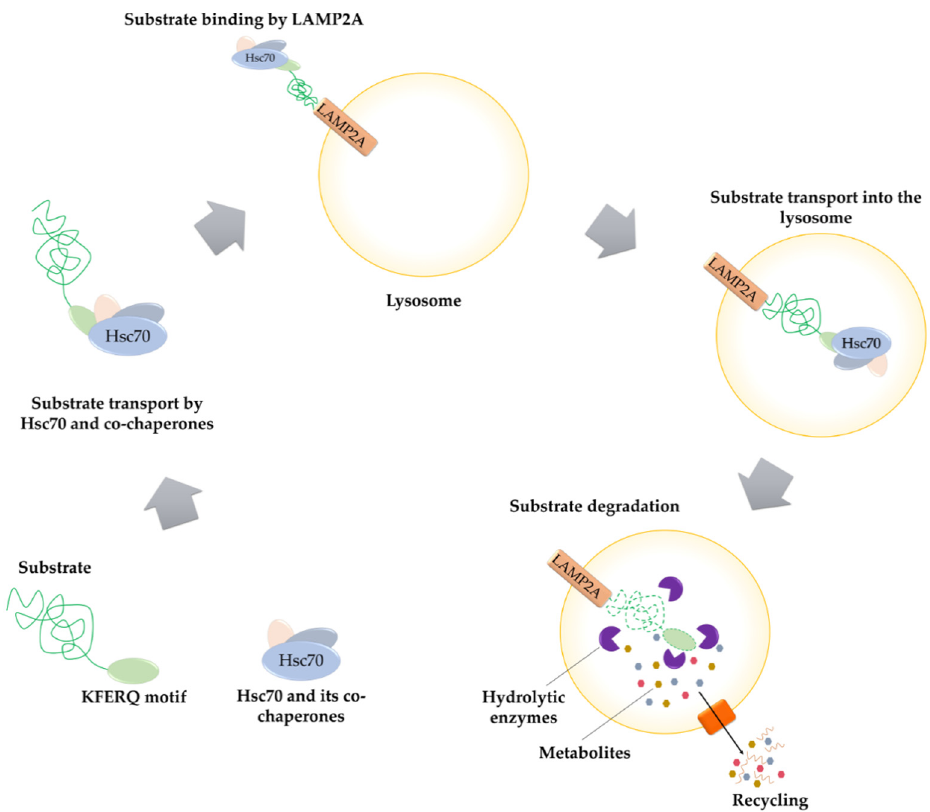
Figure 4. Chaperone-mediated autophagy. Substrate proteins with KFERQ motif are identified by Hsc70 (Heat Shock Cognate protein 70). Next, the recognized substrates are transported by Hsc70 and its co-chaperones on the lysosome surface. Delivered proteins bind to the LAMP2A (Lysosome-Associated Membrane Protein type 2A) and LAMP2A-protein complex is formed. At the final stage of the CMA process, substrate proteins are transported into the lysosome lumen and their degradation by hydrolytic enzyme occurs.